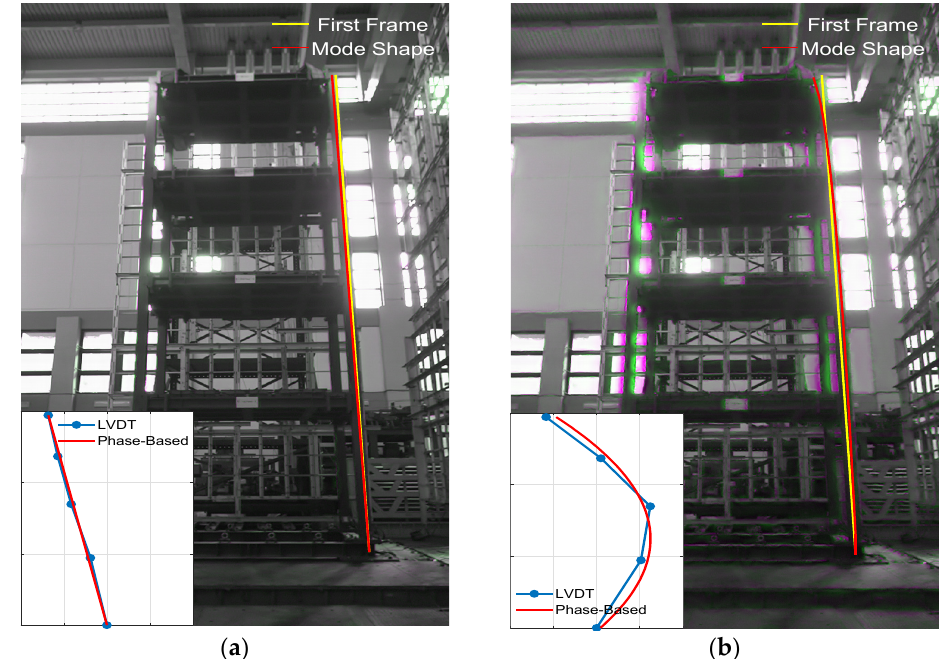
Figure 11. Identified full-field mode shapes from the phase-based motion magnification using the Riesz pyramid: ( a ) 1st mode; ( b ) 2nd mode.